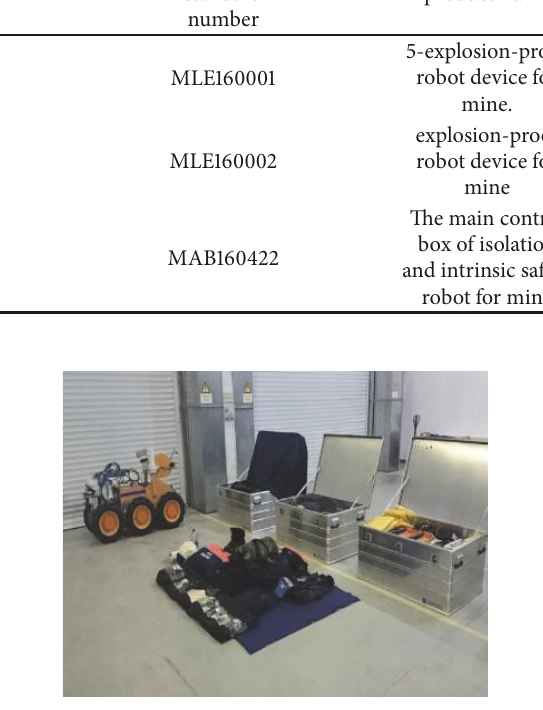
Figure 4: System of “Leader” robot.